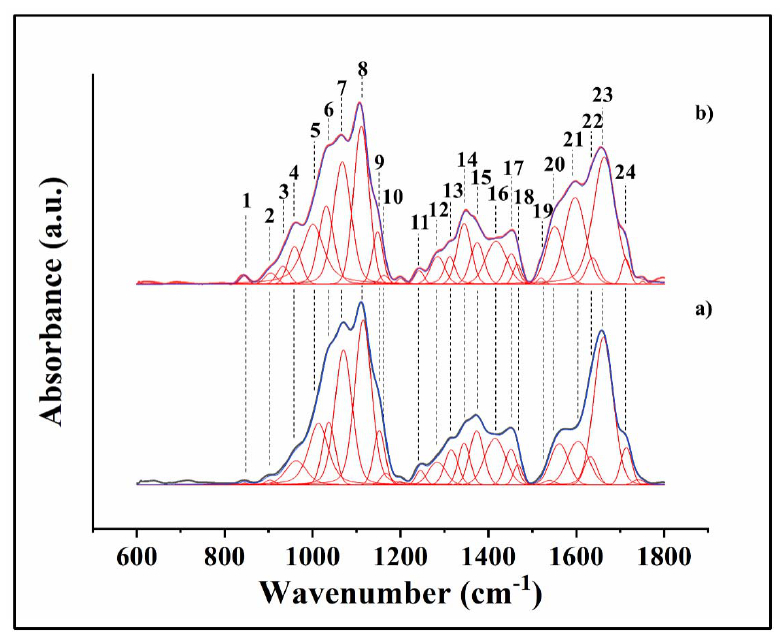
Figure 4. FTIR spectra of CS/PEO (a) and CS/PEO/BG (b) nanofibers. The numbers correspond to the positions of bands whose assignments are listed in Table 1. Table 1: List of FTIR band assignments related to CS/PEO and CS/PEO/BG.